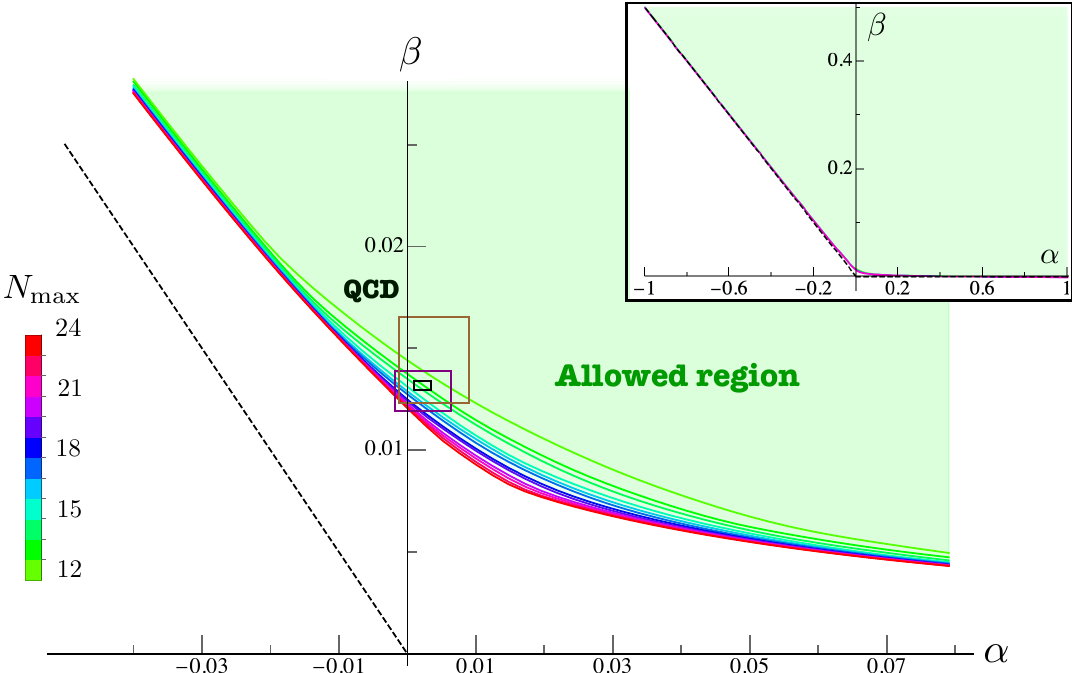
Figure 1 . Allowed region in the { α, β } space for different values of N max ranging from 12 to 23. For each N max we bound all the partial waves up to spin L max = 90 such that the spin cutoff dependence is negligible. In the inset it is shown a zoom out of the { α, β } space. The green region is allowed. The dashed lines denote the naive bounds (1.4) obtained from dispersion relations and unitarity, neglecting the effect of logarithmic branch cuts in the scattering amplitude. Our numerical bound has a non-trivial shape in the natural range α ∼ β ∼ 1 expected from naive (4 π ) 2 dimensional analysis. The three rectangles correspond to the phenomenological estimates of the QCD values for α and β : brown, purple and black rectangles are taken respectively from [19, 20], and [21]. All estimates lie inside, but close to the boundary of the allowed